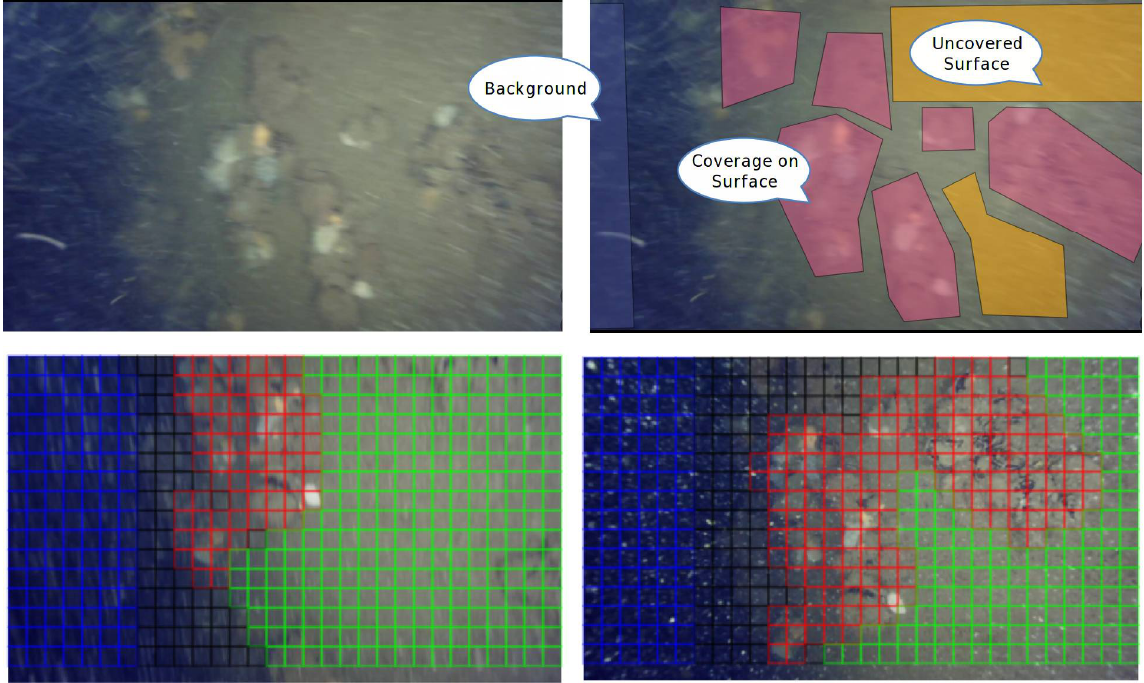
Figure 3. Example of the manual labelling of polygon path bounded regions. ( Top , Left ) Original image. ( Top , Right ) With labelled polygon regions. ( Bottom ) Segmented image